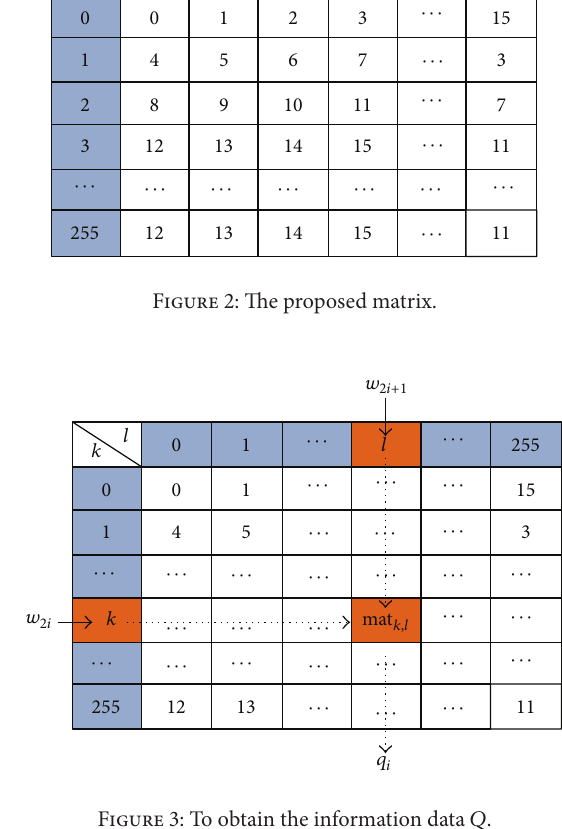
Figure 3: To obtain the information data 𝑄